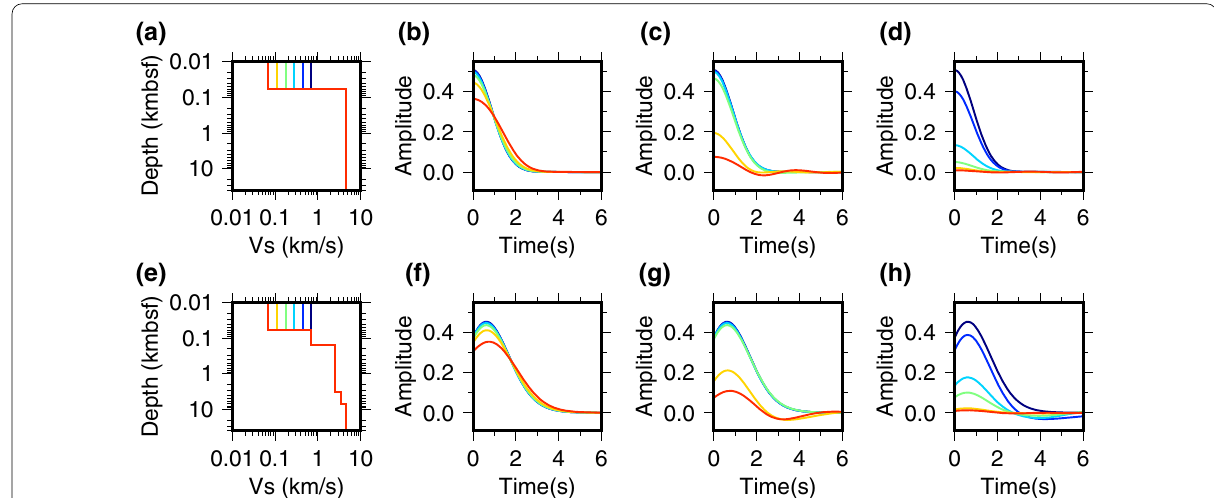
Fig. 8 Forward model experiments with a – d simple and e – h more realistic velocity models. a , e S-wave velocity (Vs) models tested through forward modeling. The models have an additional water layer with a 3-km thickness, although not shown in these panels. b – d , f – h Synthetic S-receiver functions calculated through different damping: b , f without damping, c , g with a damping factor of 0.001, and d , h with a damping factor of 0.01. Line colors correspond to those in a and e